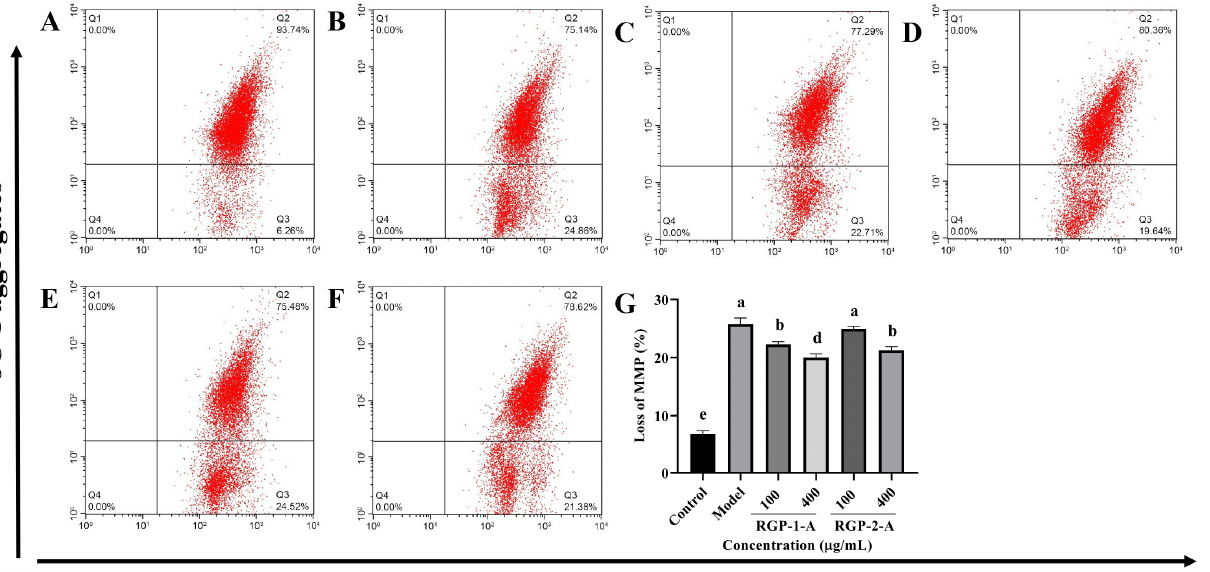
Figure 4. E ff ect of RGP pretreatment on ROS levels in LPS-induced IPEC-J2 cells. ( A ): Control group; ( B ): model group; ( C ): RGP-1-A low concentration; ( D ): RGP-1-A high concentration; ( E ): RGP-2-A low concentration; ( F ): RGP-2-A high concentration; ( G ):Quantitative analysis of ROS content in cells. RGP-1-A: decolorized pure polysaccharides of RGP obtained using AB-8 macroporous resin; RGP-2-A: decolorized pure polysaccharides of RGP obtained using H 2 O 2 . On the bar graphs, di ff er- ent lowercase le tt ers signify a signi fi cant di ff erence ( p < 0.05).